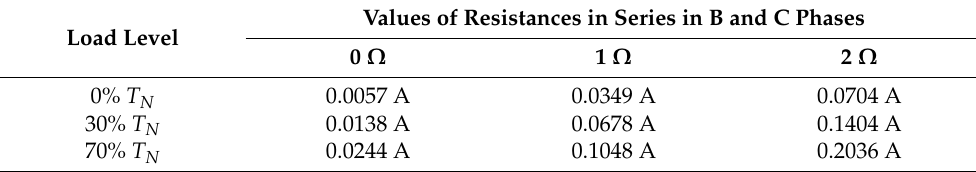
Table 5. Simulation data of motor negative sequence current at 30